Question: Provide a one-line summary of what is displayed.
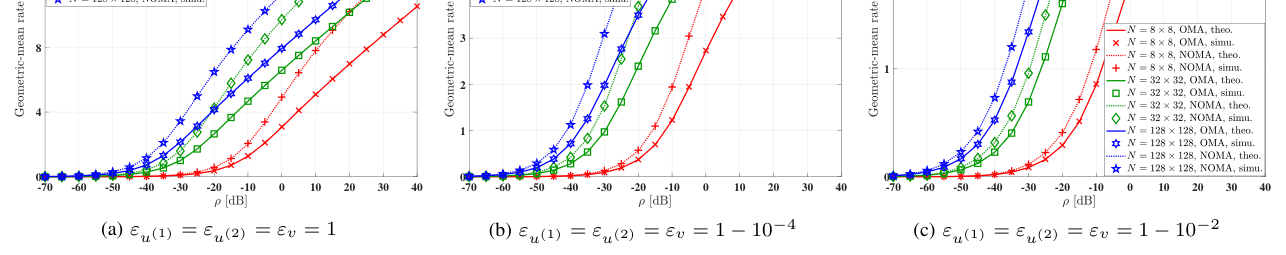
Answer: Theoretical analysis and simulation results of the geometric-mean rate RRM with different hardware quality factors.